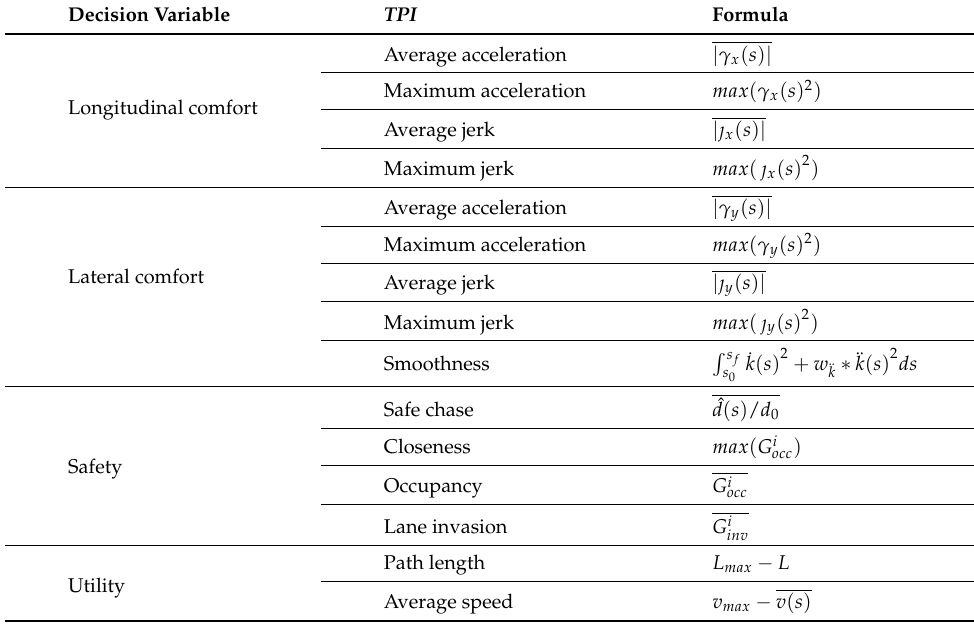
Table 1. Trajectory Performance Indicators and decision variables of trajectory